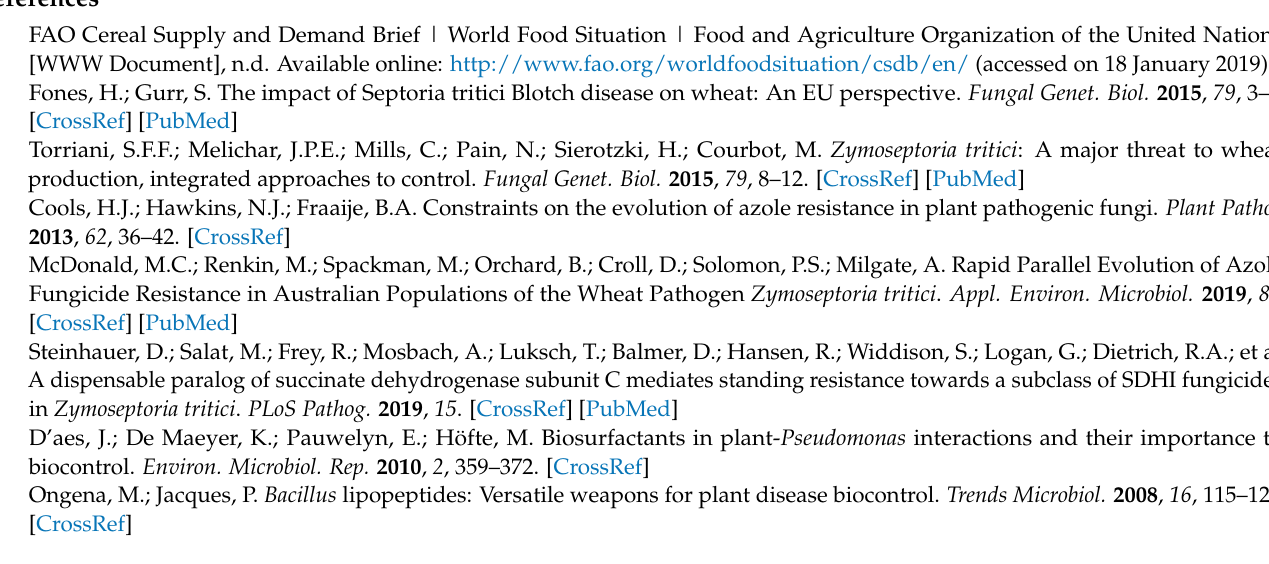
Table S1: Half-maximal inhibitory concentration (IC 50 ) values obtained for 22 Zymoseptoria tritici strains differing in their resistance level to DMI fungicides, towards five DMI molecules and the rhamnolipid molecule Rh-Est-C12. Supplementary Table S2: Resistance factors obtained for 22 Zymoseptoria tritici strains differing in their resistance level to DMI fungicides, towards five DMI molecules and the rhamnolipid molecule Rh-Est-C12, calculated from the IC 50 values presented in the Supplementary Table 1. Resistance factors correspond to the ratio between the IC 50 value of a given strain and the IC 50 value of the sensitive reference strain